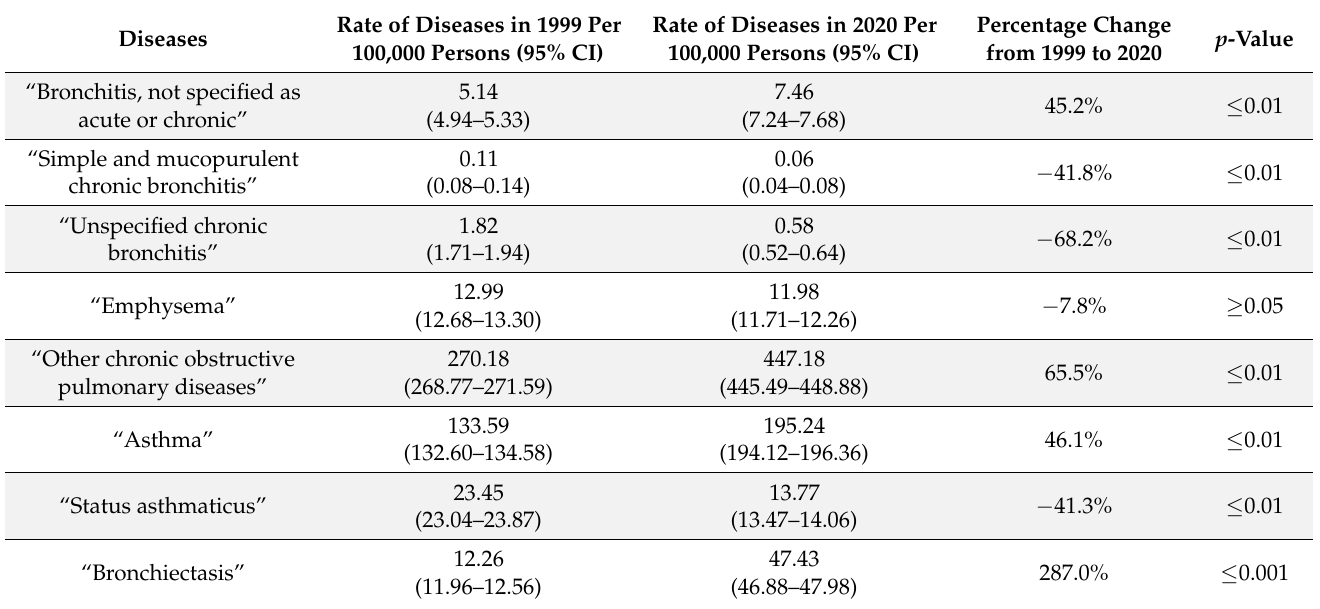
Table 2. Percentage change in the hospital admission rates for chronic lower respiratory